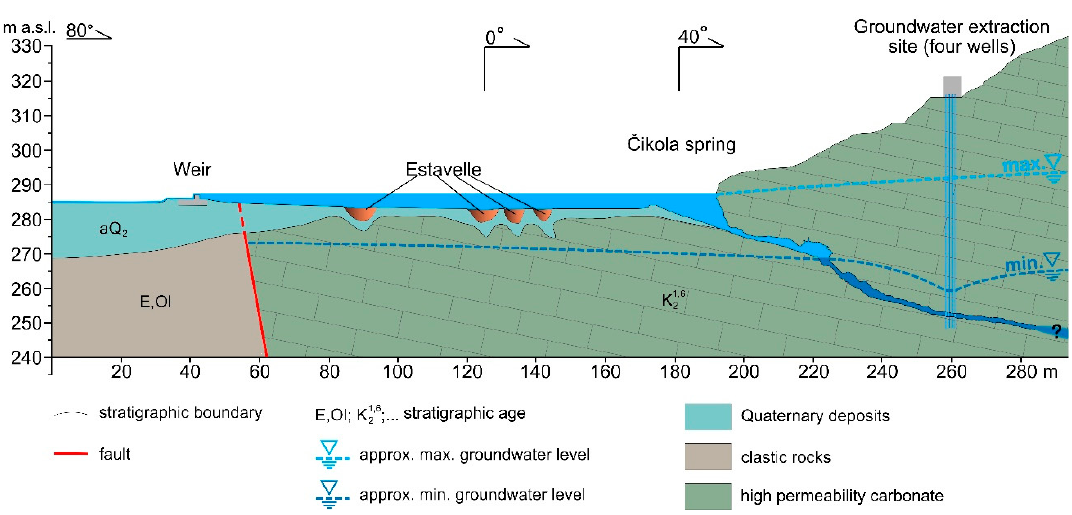
Figure 4. Schematized hydrogeological profile of the Č ikola spring site.